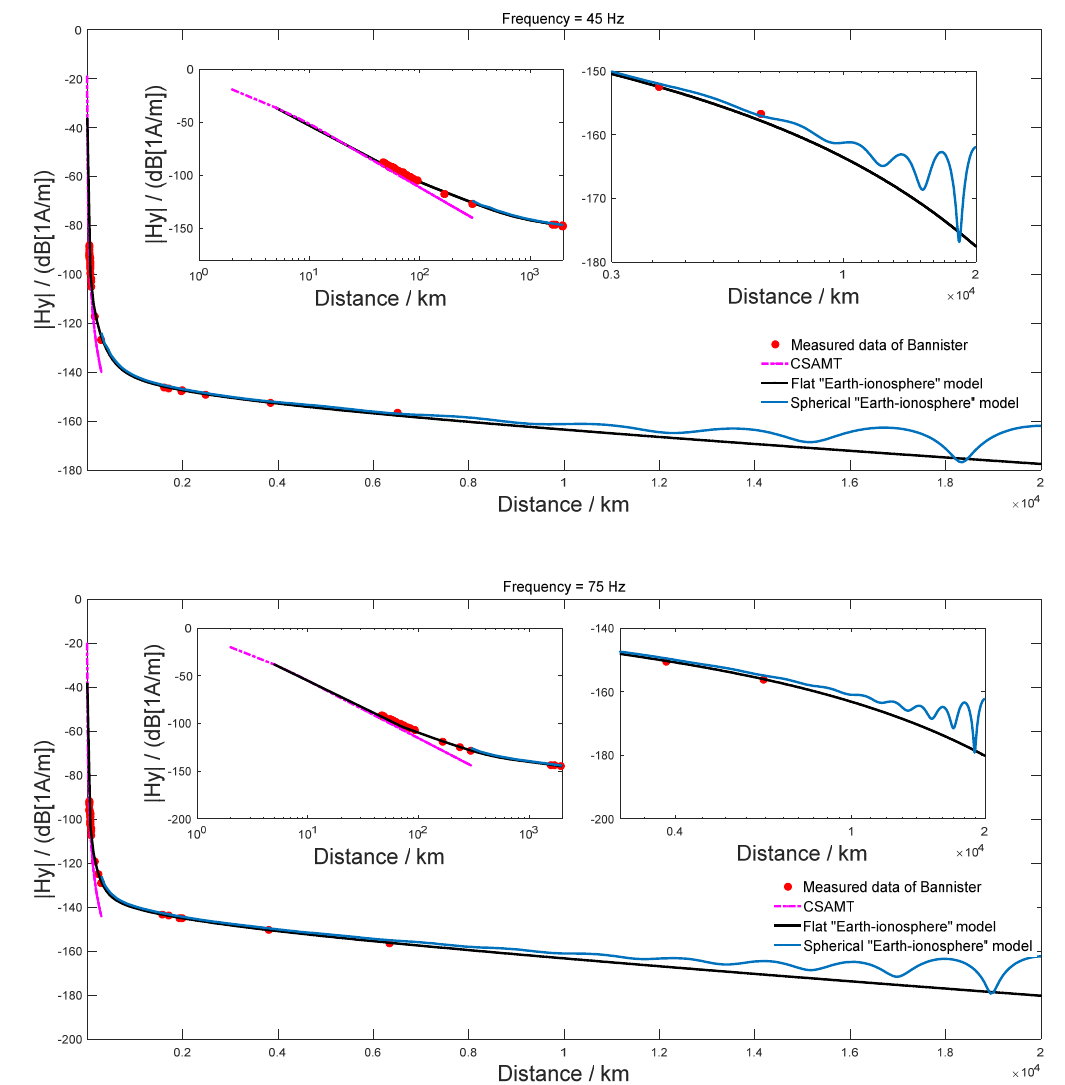
Figure 5. Comparison of the amplitude and variation trend of the horizontal electromagnetic strength. The dots are the measurement data that Bannister obtained using the U.S. Navy ELF Wisconsin test facility, the dotted line is the result of CSAMT, the solid black line is the result of the plate model of reference [24], and the solid blue line is the result of the spherical cavity model in this